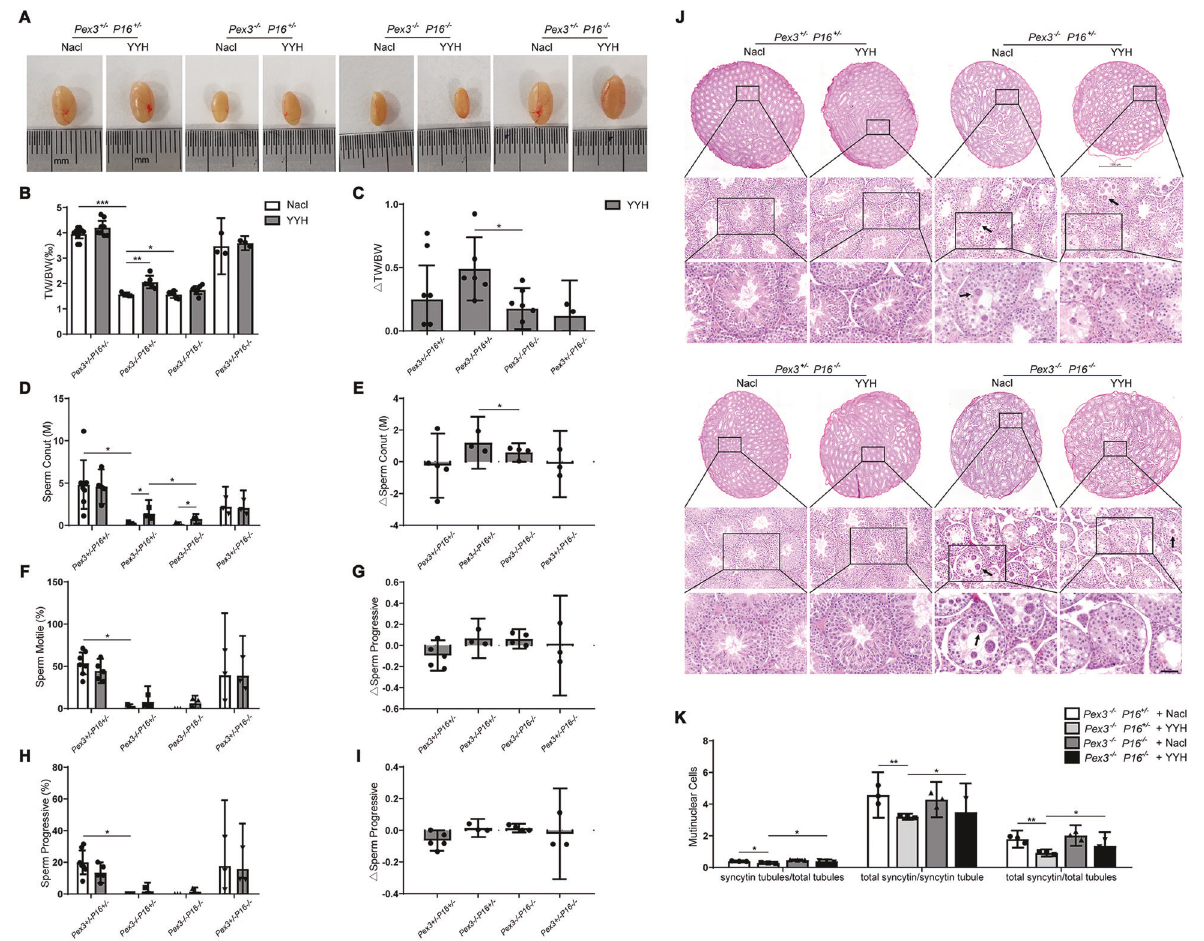
Fig. 6 Impacts of YYH treatment on spermatogenesis-related indices in mice with different genotypes ( n = 4). A Representative image of testicular sizes. B Testicular weight ratios. C Changes in the testicular weight ratio. D Sperm counts. E Changes in the sperm count. F Sperm motility. G Changes in sperm motility. H Sperm forward motility. I Changes in sperm forward motility. J Images of HE staining in testes. Scale bars: 50 μ m. K Statistics regarding syncytial multinucleated cells in the testicular